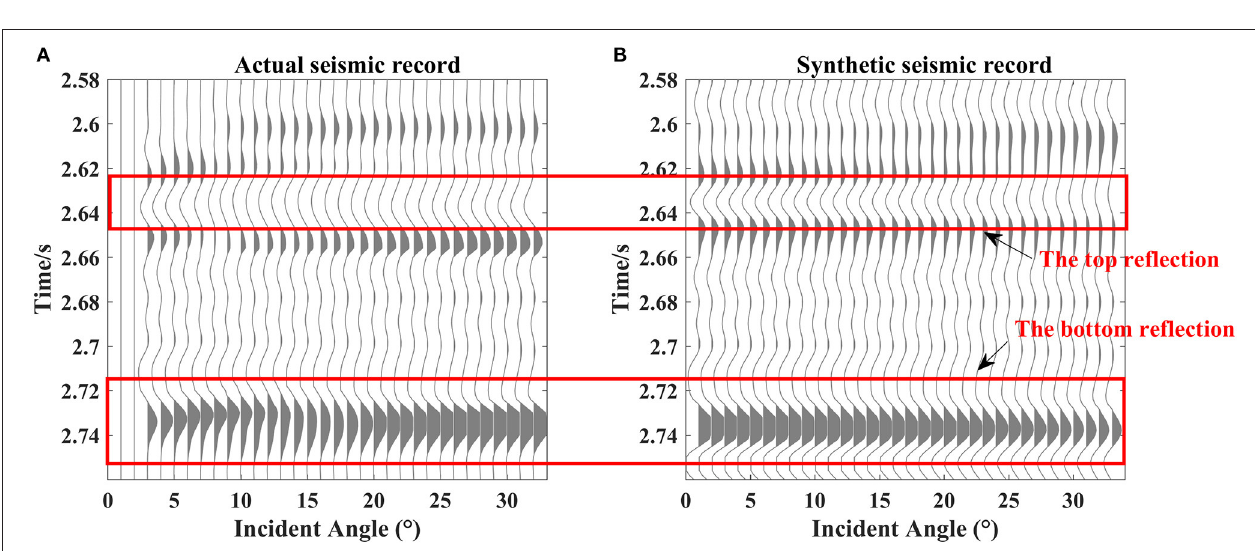
FIGURE 13 | (A,B) A comparison of actual seismic records and synthetic seismic